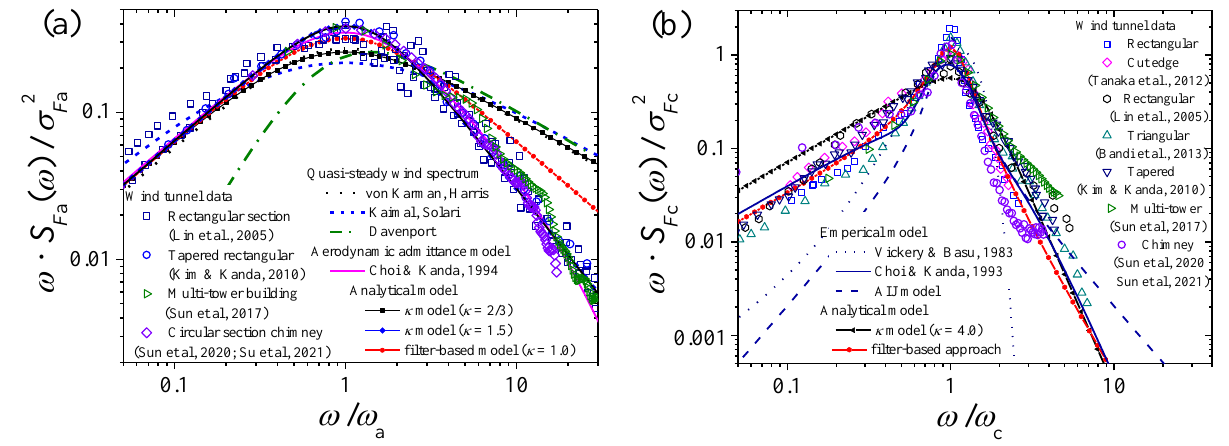
Figure 4. Comparison between the spectral model and experimental data reported in relevant literatures [45–55]. ( a ) along-wind; ( b ) cross-wind. The cross-wind excitation usually has a narrow-banded spectral characteristic, due to the vortex-induced turbulence. A quadratic polynomial is adopted to the model of the cross-wind spectrum, provided by Equation (21), with the subscript “c” denoting a (cid:2) (cid:3) ω S F c ( ω ) / σ 2 “cross-wind”. In the equation, ω c = argmax is a characteristic frequency F c (cid:114) (cid:82) ∞ d ω is the of the cross-wind load, related with the vortex frequency. λ c = 1 ω c (cid:113) + 1 ) 2 − 4 is a dissipation ( λ 2 bandwidth parameter ranging from 1 to infinity. ρ c = c parameter. Note that, as the bandwidth becomes increasingly narrow, λ c approaches 1. Otherwise, as λ c tends to infinity, the result converges to the along-wind spectrum. This model agrees well with the experimental data for various slender structures reported in the literatures, as shown in Figure